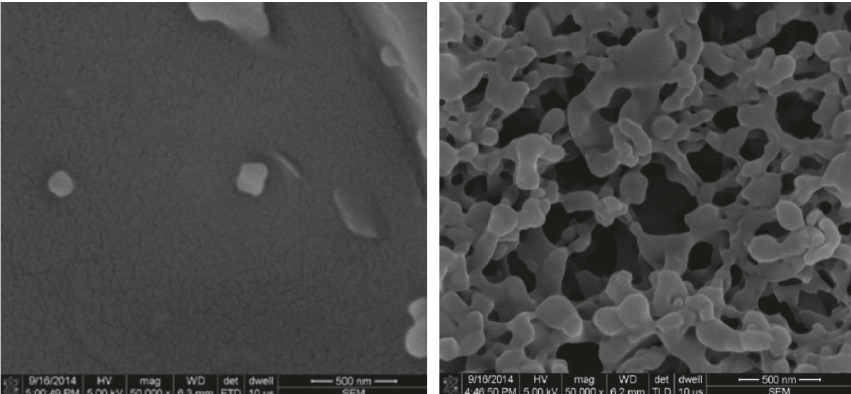
Figure 4: SEM images of pure (a) β -CD and (b) Cu- β -CD catalysts.